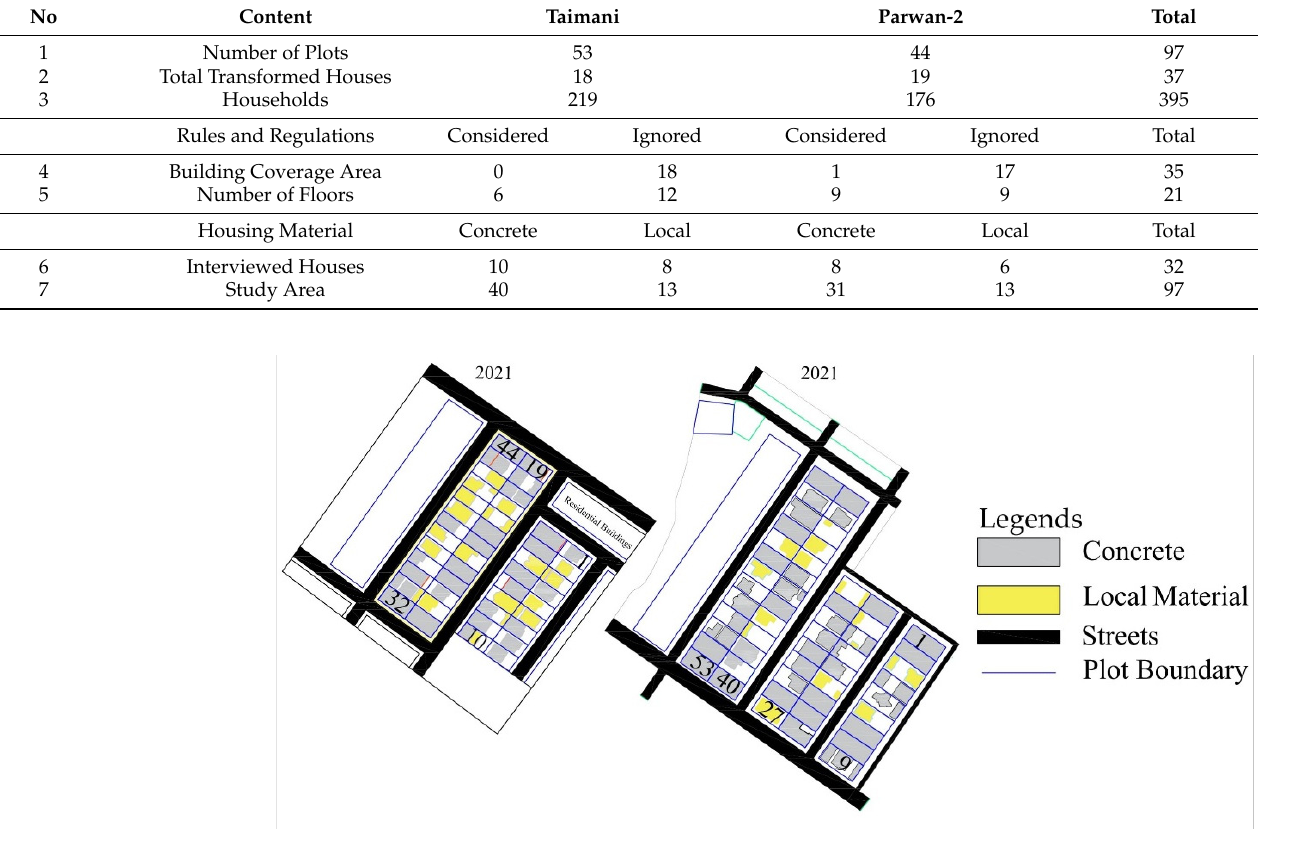
Figure 5. Three-Dimensional Version of Current Condition of Study Areas and Surveyed Houses: ( a ) Parwan-2; ( b ) Taimani.